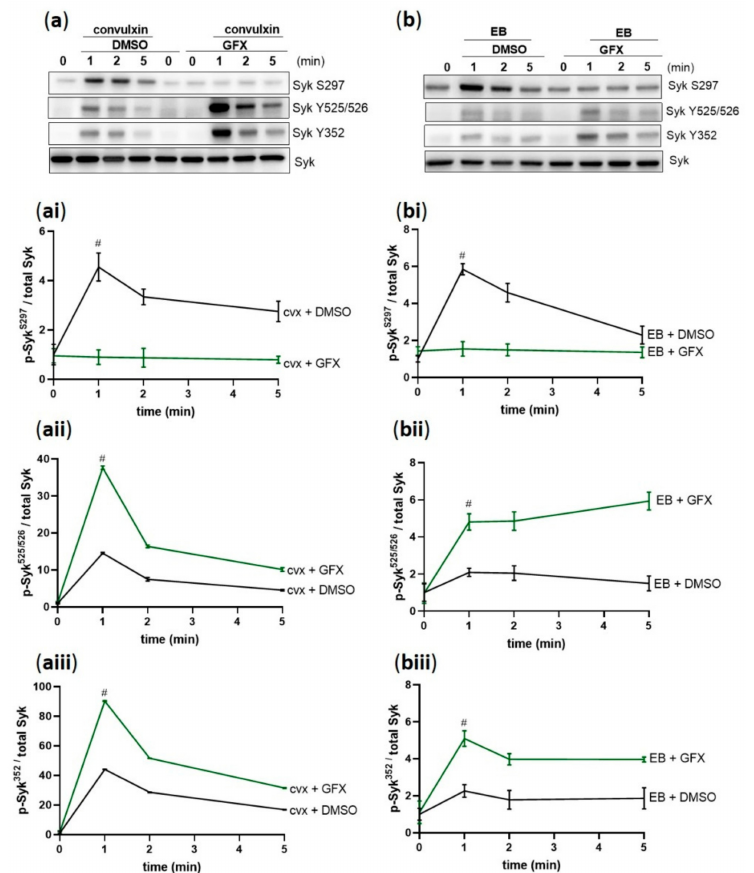
Figure 7. Syk phosphorylation is di ff erentially regulated by PKC. Washed human platelets were pre-incubated with DMSO (vehicle control) or with pan-PKC inhibitor GF109203X (5 µ M) at 37 ◦ C for 5 min prior to stimulation with ( a ) 50 ng / mL cvx or ( b ) 0.5% ( v / v ) EB. Platelet aggregation was stopped by adding Laemmli bu ff er after 1, 2, or 5 min of stimulation under stirring conditions. The kinetics of the phosphorylation of Syk on ( ai , bi ) S297, ( aii , bii ) Y525 / 526, and ( aiii , biii ) Y352 compared to total Syk are represented as means ± SD from three independent experiments with platelets from three healthy donors. # p < 0.0001, DMSO-versus GFX-treated platelets at 1 min in response to cvx or